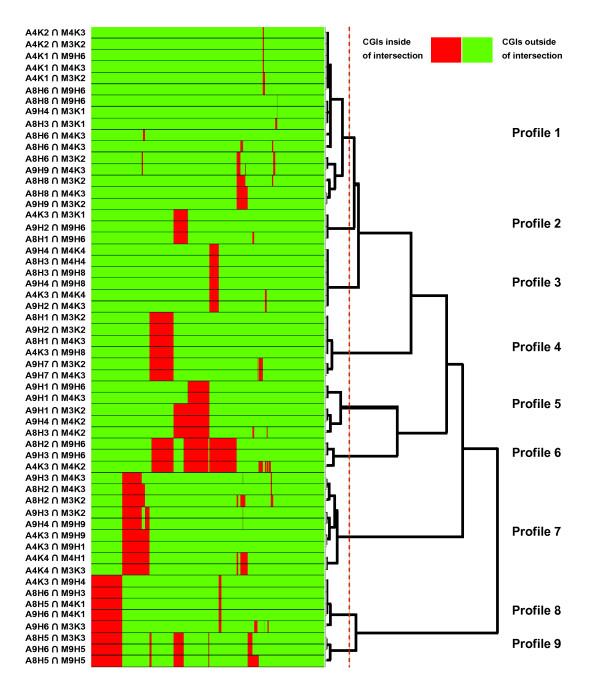
Determining non-redundant CGI profiles. Elimination of redundant CGI profiles. Initially, 55 profiles (relations between CGI sequence attributes and methylation classes linked by the probability of intersection) were identified. We grouped all profiles recognizing the same observation using a column/row hierarchical clustering, and summarize each cluster by their most representative prototype (i.e., the most supported relation of each cluster). The validity index we used (see methods) suggests a partition into 9 final profiles.